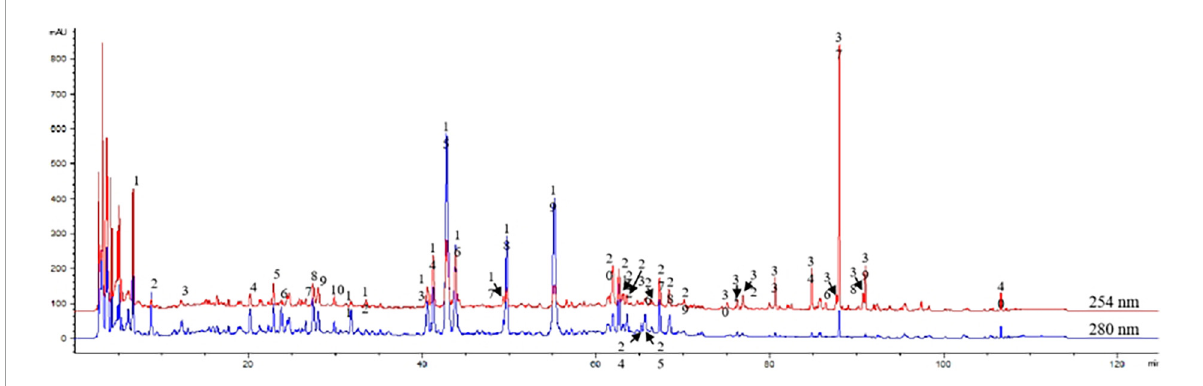
FIGURE1 Assessment of Buzhong Yiqi decoction (BZYQD) quality using a multi-component high purity liquid chromatography (HPLC) fingerprint. The picture shows the typical chromatogram of BZYQD at 254 and 280 nm.